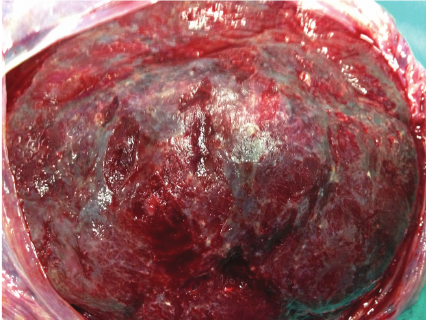
Figure 3: The image of the placenta from Case 1. The mass is protruding from its surface with rich vascular network.